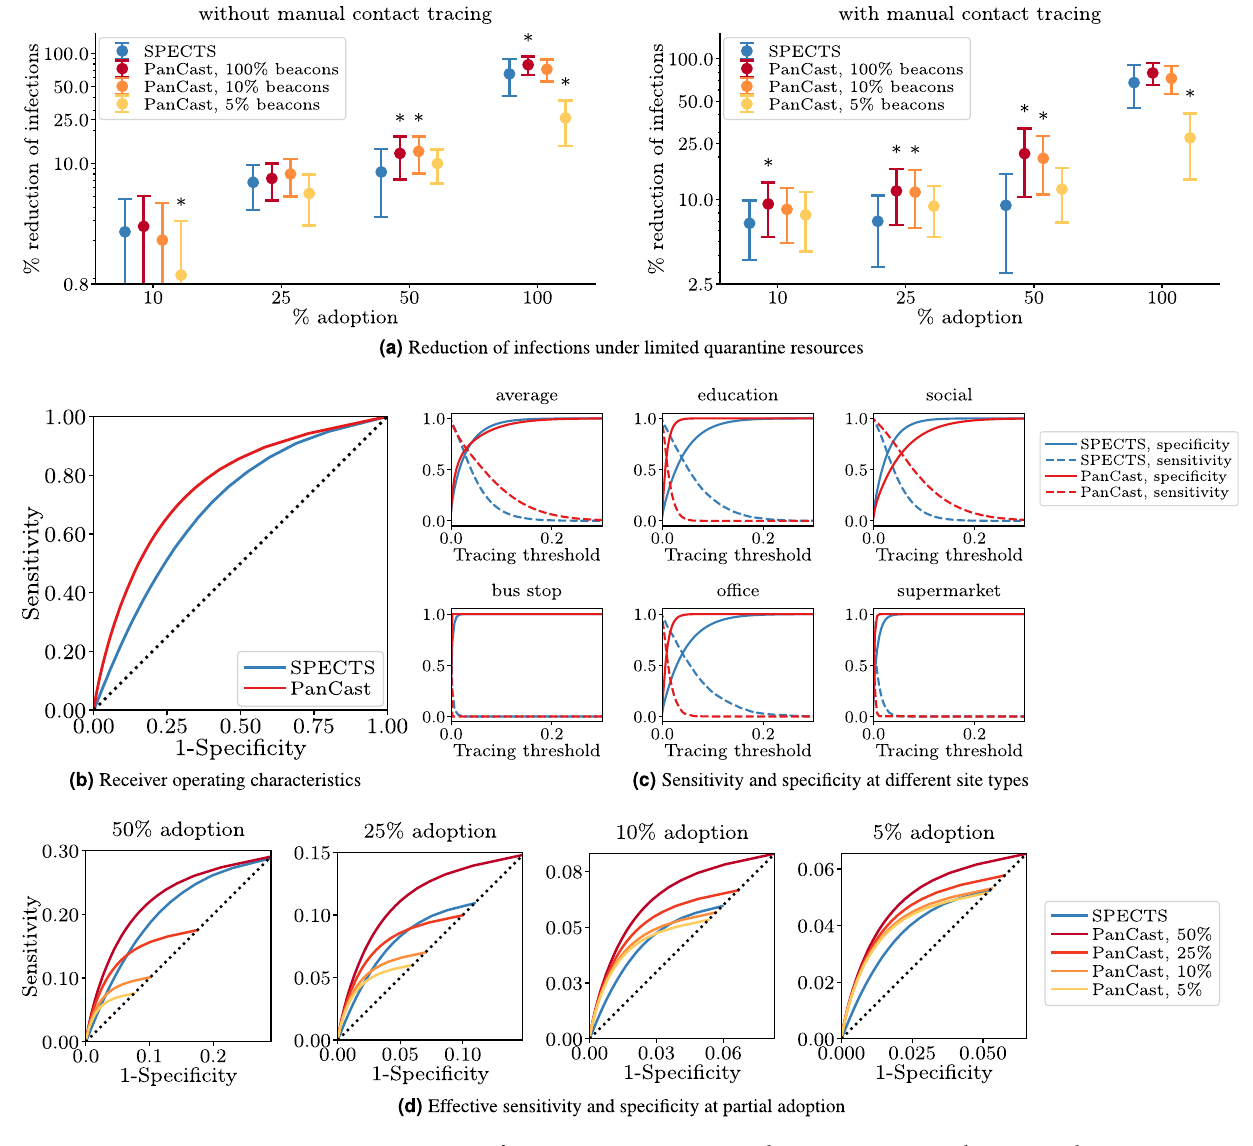
Figure 3. Leveraging site information to improve tracing decisions. We assume that PanCast has access to the site-dependent transmission rates, while SPECTS can only use an average value to inform tracing decisions. ( a ) The reduction of infections achieved by PanCast and SPECTS with and without manual tracing under the constraint that at any given time a maximum of 10% of the population can be quarantined due to tracing decisions (in addition to positively tested individuals and their household members). In both figures, points represent averages of 400 random roll-outs of the simulation, error bars correspond to plus and minus one standard deviation, and the sign ∗ indicates a statistically significant difference (two-sample t-test; p value < 0.05 ) between PanCast and SPECTS. ( b ) ROC curves defined as true positive rate (sensitivity) against false positive rate ( 1 − specificity ). ( c ) Sensitivity and specificity stratified by site type. ( d ) Effective sensitivity and specificity (see text) for different adoption levels, incorporating both interaction with manual contact tracing and utilization of environmental information. PanCast outperforms SPECTS if adoption is low or the percentage of sites with beacons is